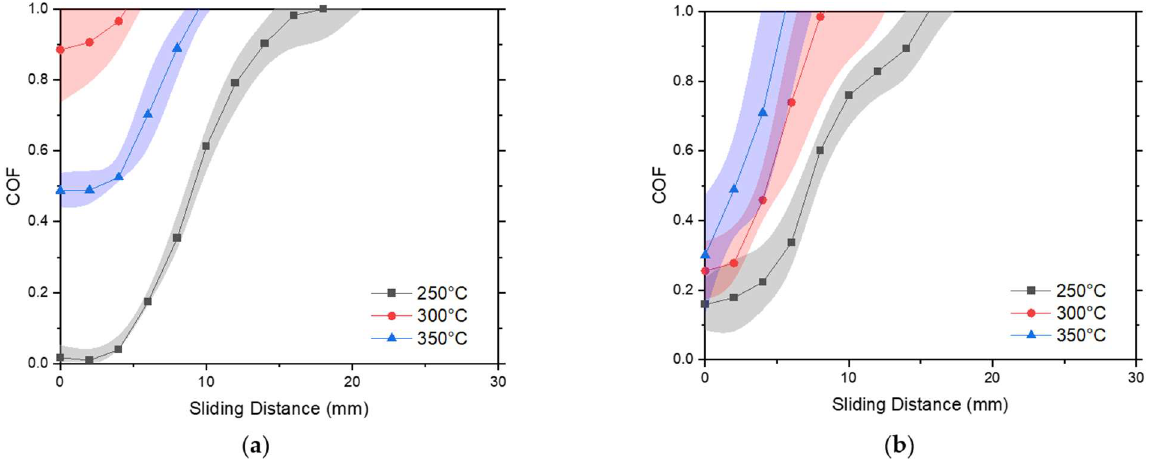
Figure 2. Friction evaluation under different temperature conditions: ( a ) lubricant A; ( b ) lubricant B. The connected scatter lines represent the average coefficient of friction values while the shadows represent the standard